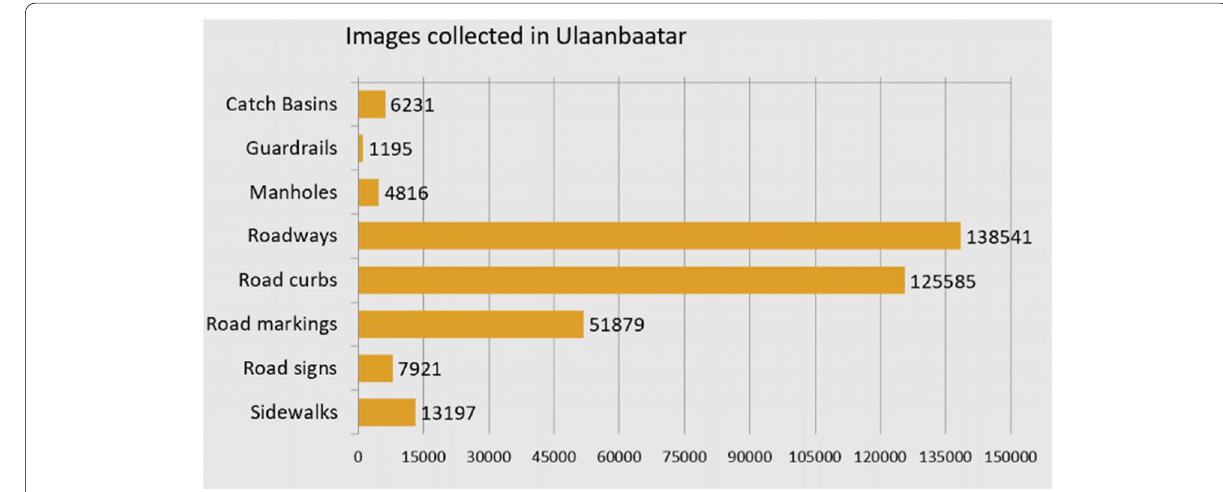
Fig. 17 Number of images with different facilities